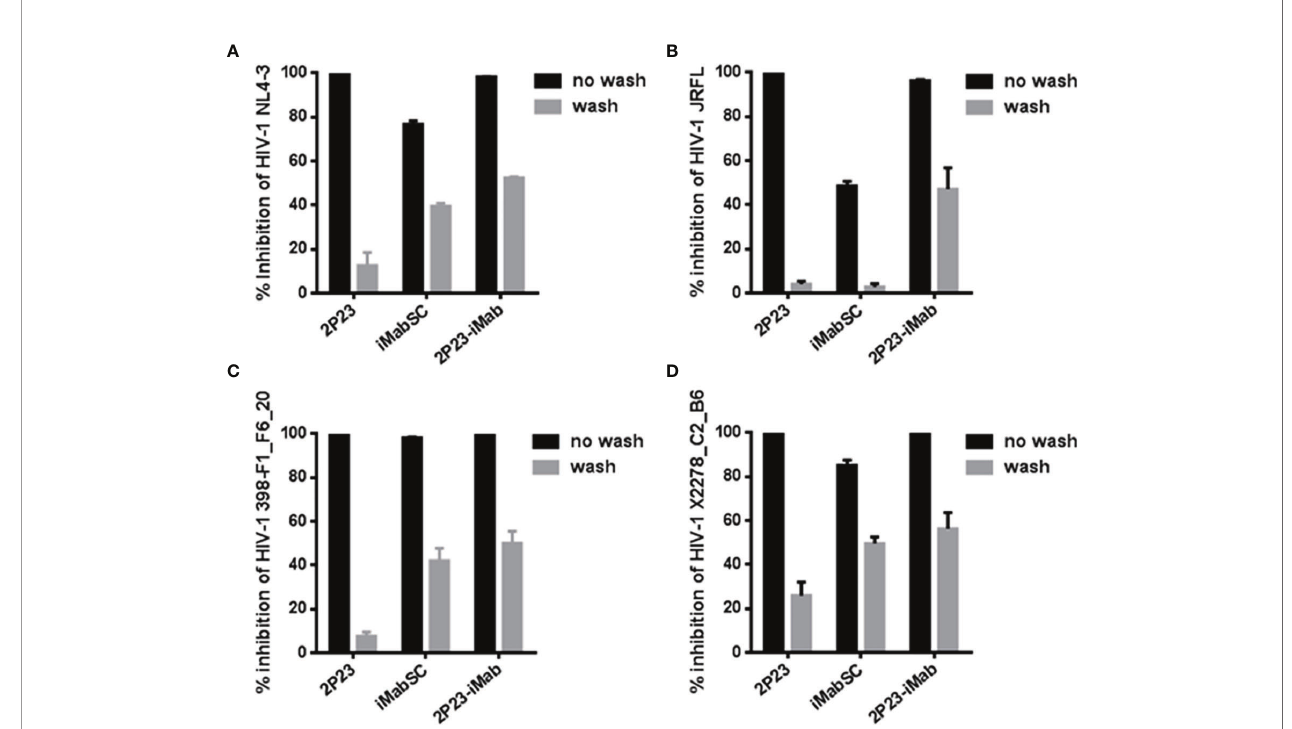
FIGURE 4 | Inhibitory activities of cell membrane-anchored inhibitors against HIV-1. Similar to the described in Figure 3 , an inhibitor was preincubated cells, followed by washes, and its sustained activity in inhibiting infection of an HIV-1 pseudovirus (NL4-3, JRFL, 398-F1_F6_20, or X2278_C2_B6) was measured by the single-cycle infection assay. The experiments were performed in triplicate and repeated three times, and data are expressed as means ± SD.